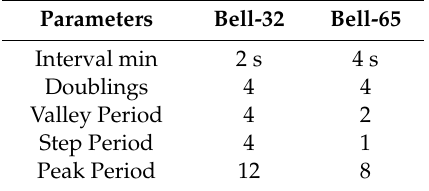
Figure 10. Bell-65 Configuration. Table 5. Configuration parameters for the Bell-32 and Bell-65 configurations.